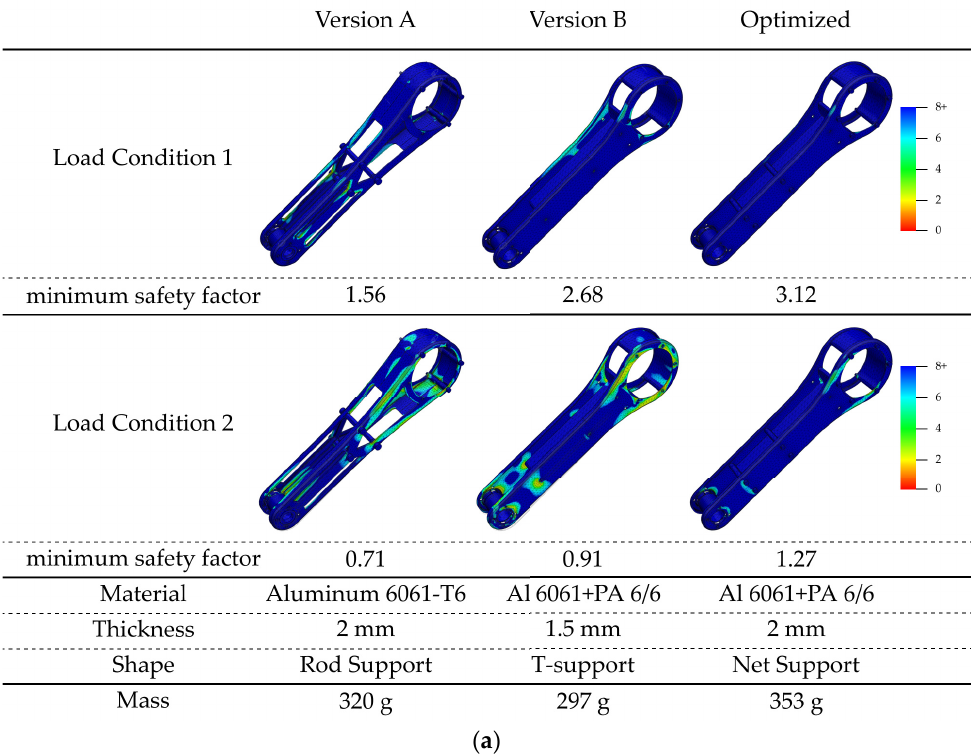
Figure 15. Analysis of condition 2 for the upper link. From left to right are the safety factor, stress, and displacement.